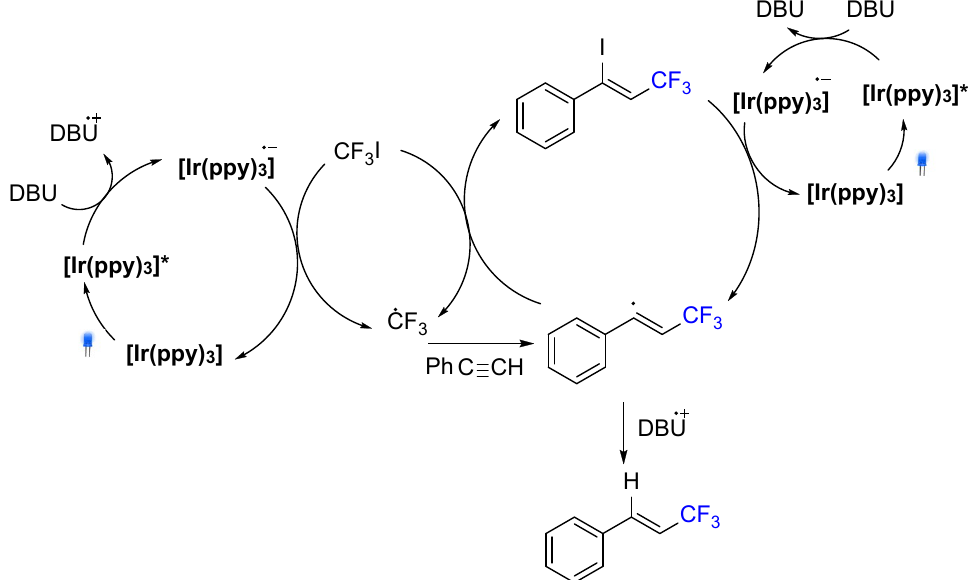
Figure 6. Hydrotrifluoromethylation of alkynes developed by Cho’s group.